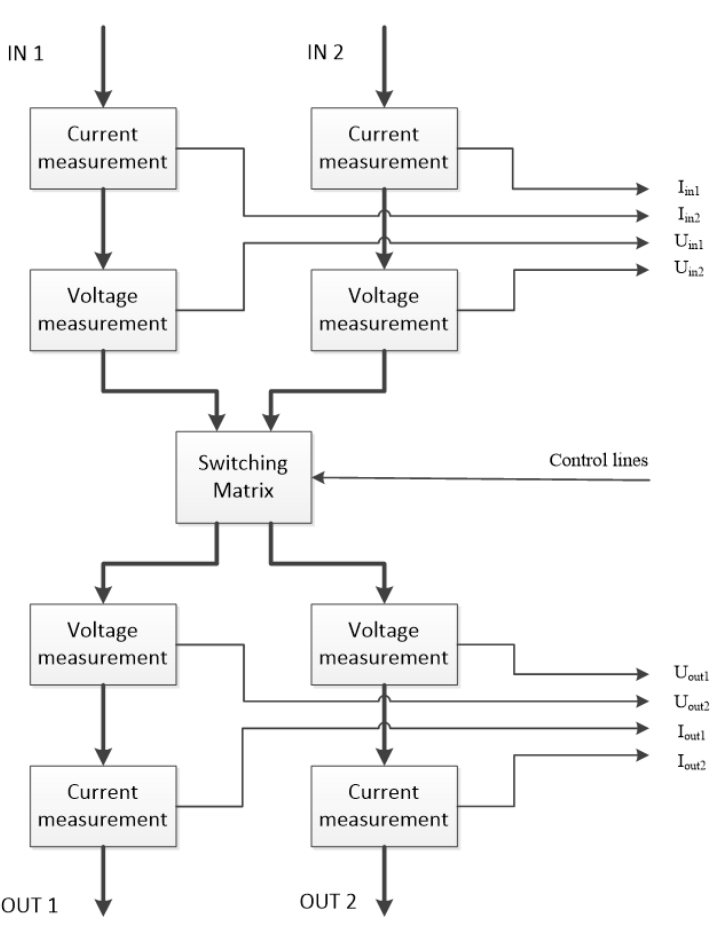
Figure 6. Power line measuring